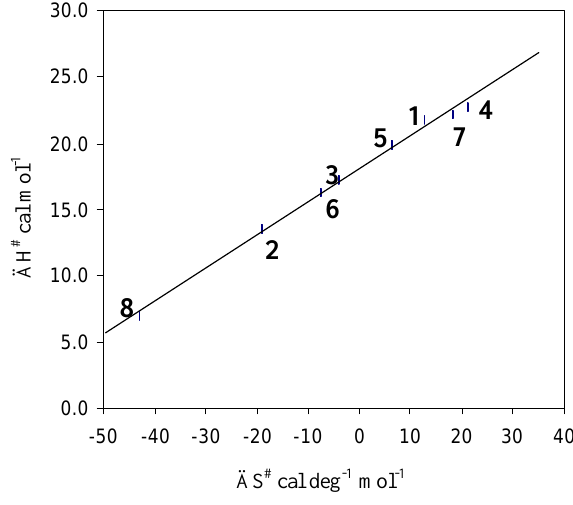
Figure 5Figure 5. Isokinetic relation ship of Ä H # versus Ä S # plot for oxidations of some amino acids by Diperiodatocuprate(III). 1=Glycine ,2 = â -Alanine, 3 = á -Alanine, 4 =Phenylalanine, 5= Leucine, 6= Valine, 7 = Serine , 8=